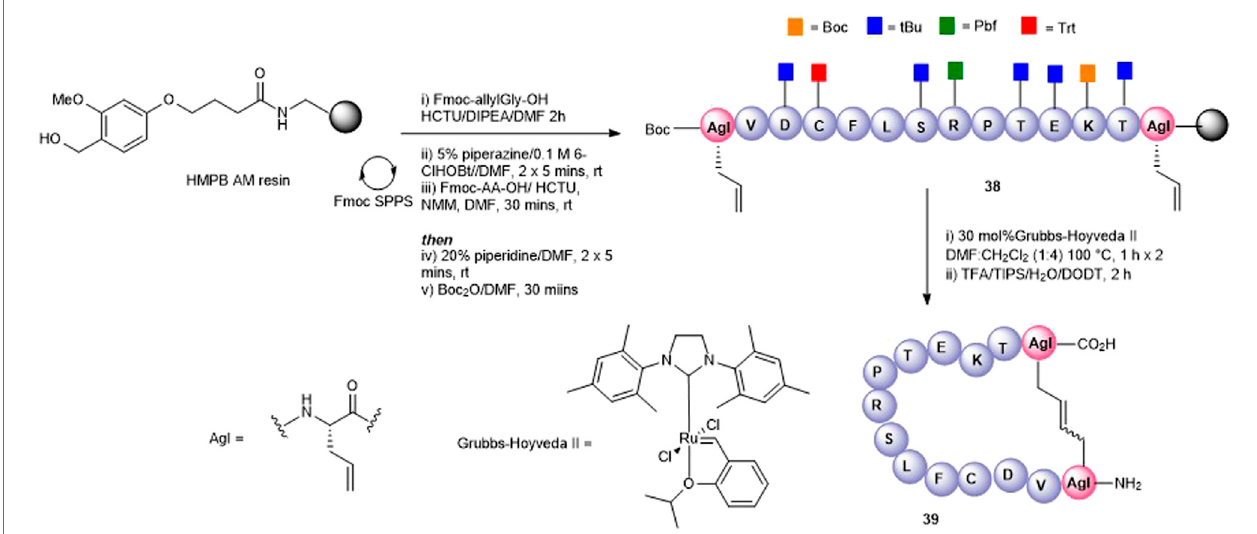
FIGURE 9 | Synthesis of an all-carba head-to-tail macrocycle 37 via the introduction allylGly (AgI) at the C- and N -termini and ring-closing metathesis.